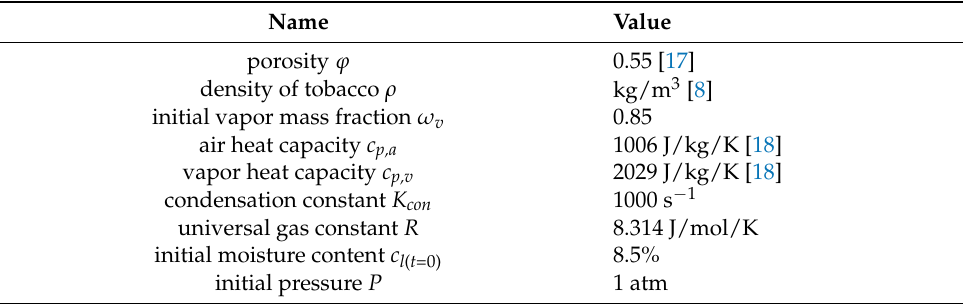
Figure 2. Heat and mass transfer within the heaped tobacco strips in the rewetting session. Table 1. Physical properties of the heaped tobacco strips.